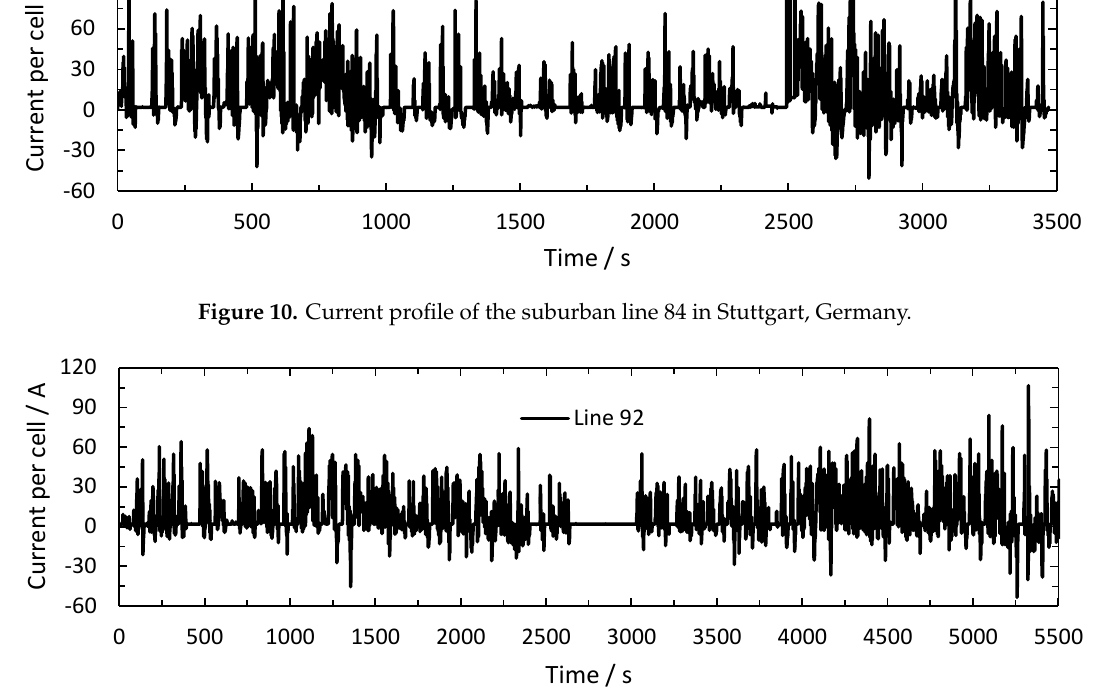
Figure 11. Current profile of the urban line 92 in Stuttgart, Germany.